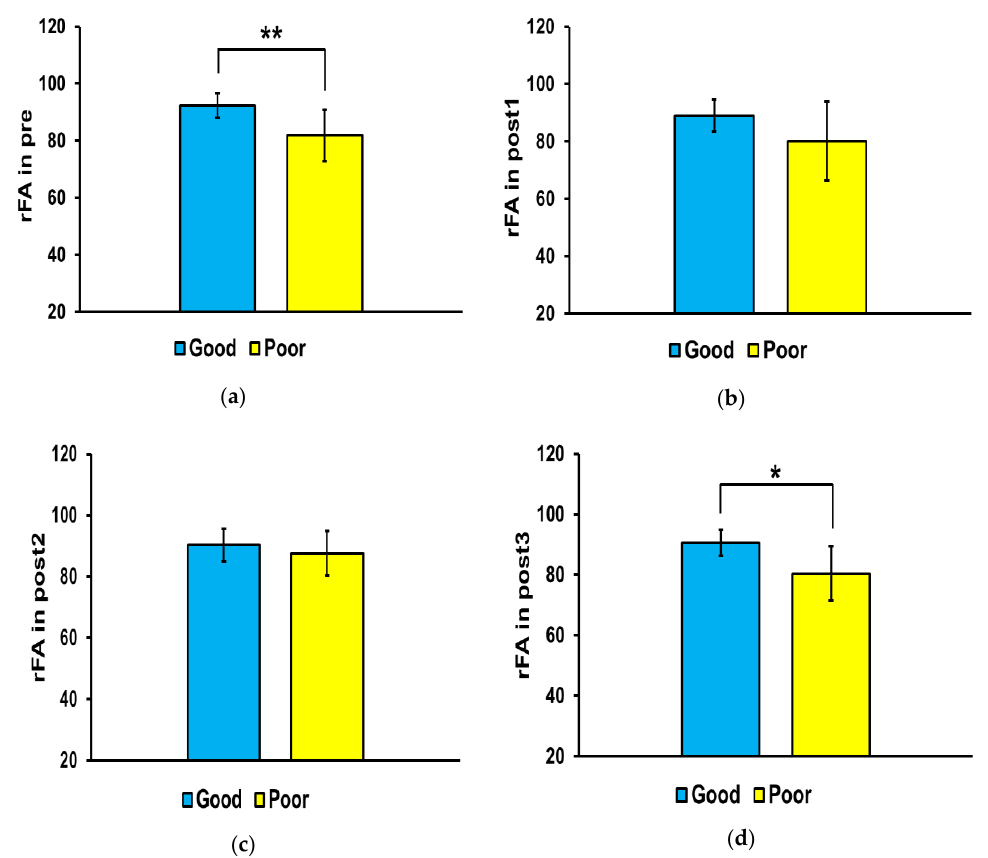
Figure 4. Mean fractional anisotropy (FA) ratios in the corticospinal tract. In the affected side, the mean FA ratio was significantly higher in the good outcome group than that in the poor outcome group at pre (* p < 0.01) and post3 (* p < 0.05). Abbreviations: ( a ) baseline (pre), ( b ) 3 weeks after stroke onset (post1), ( c ) 3 months (post2), and ( d ) 6 months (post3). ** p < 0.01. 3.3. Correlation of FA Values and FA Ratio at Pre with the Sum of BMS Score at Post3 Pearson’s correlation analysis showed that FA values (R = 0.8, ** p < 0.01) and FA ratio (R = 0.649, * p < 0.05) at pre significantly correlated with the sum of BMS scores at post3 (Figure 5).